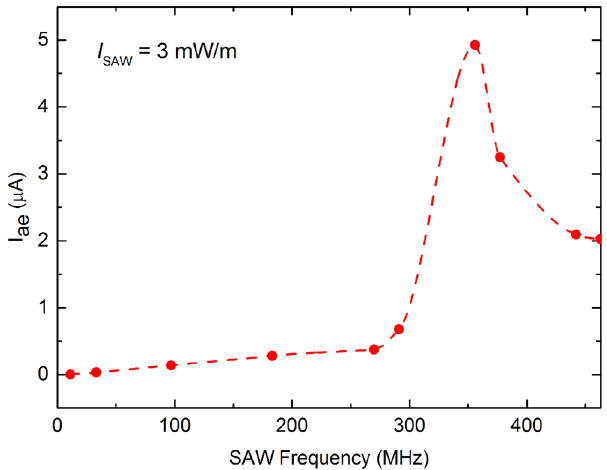
Figure 3. Acoustoelectric current as a function of SAW frequency, extracted from fitting to raw data. Spline (dashed line) is a guide to the eye only. A sharp increase in measured acoustoelectric current is observed at f SAW = 356